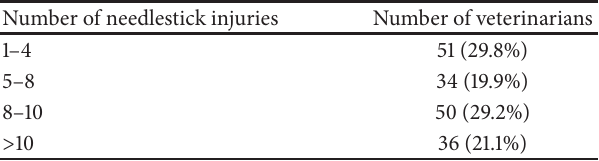
Table 1: Number of needlestick injuries reported by